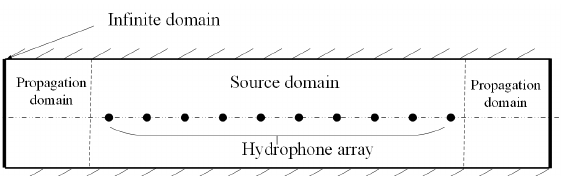
Figure 7. Boundary condition of sound simulation domain and hydrophone